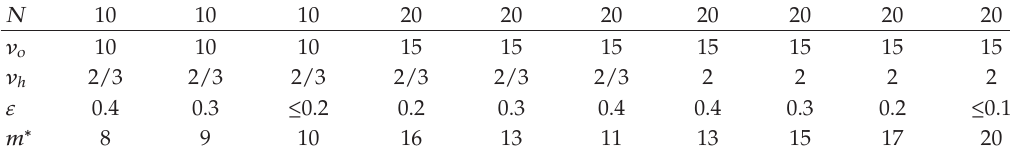
Table 4: Solutions for the problem (cid:3) 4.1 (cid:4)